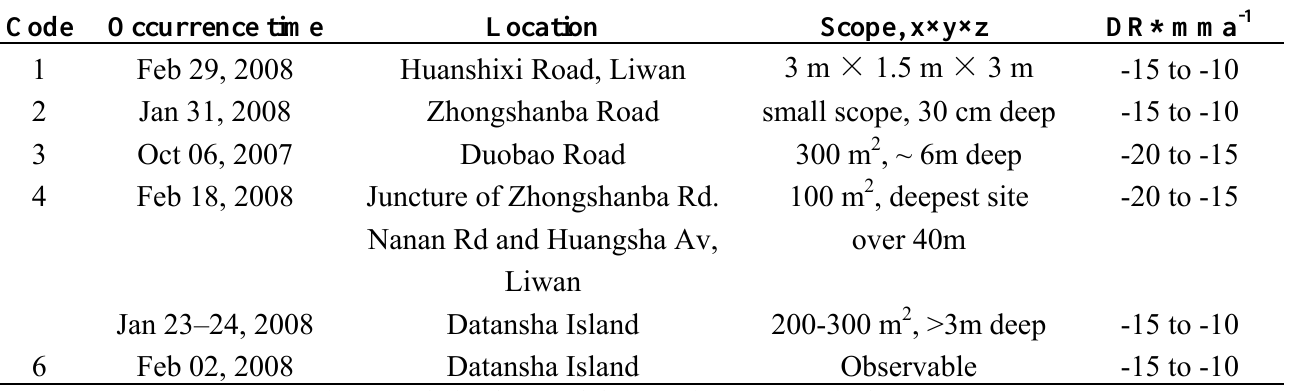
Table 2. Ground collapse accidents in Guangzhou in 2007–2008 are coded from 1 to 6 in Figure